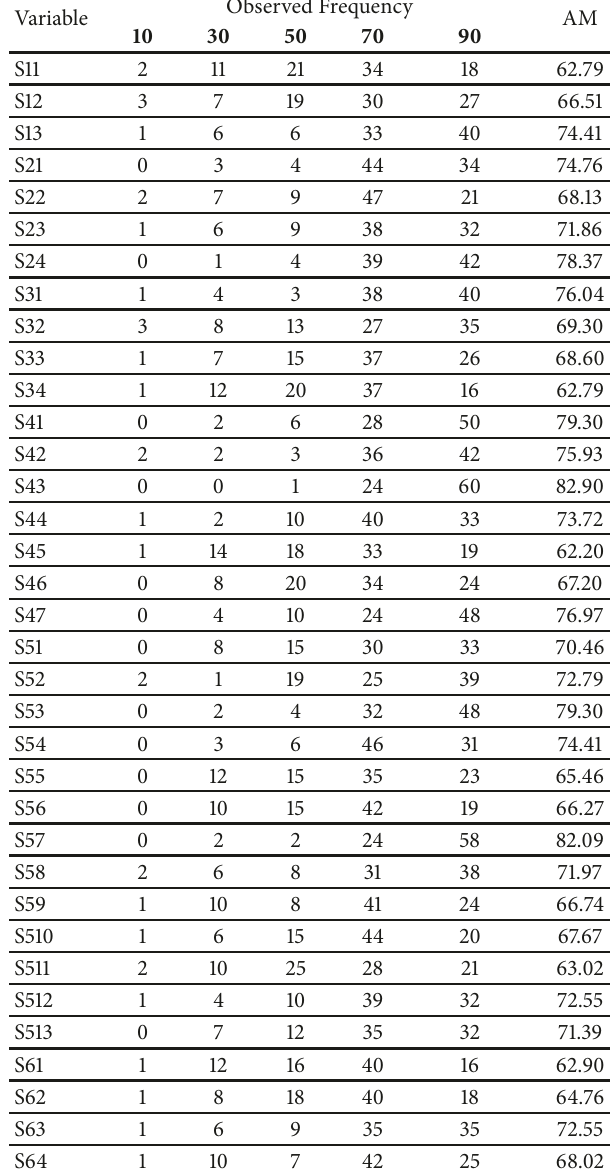
Table 2: Number of frequencies and arithmetic mean for main